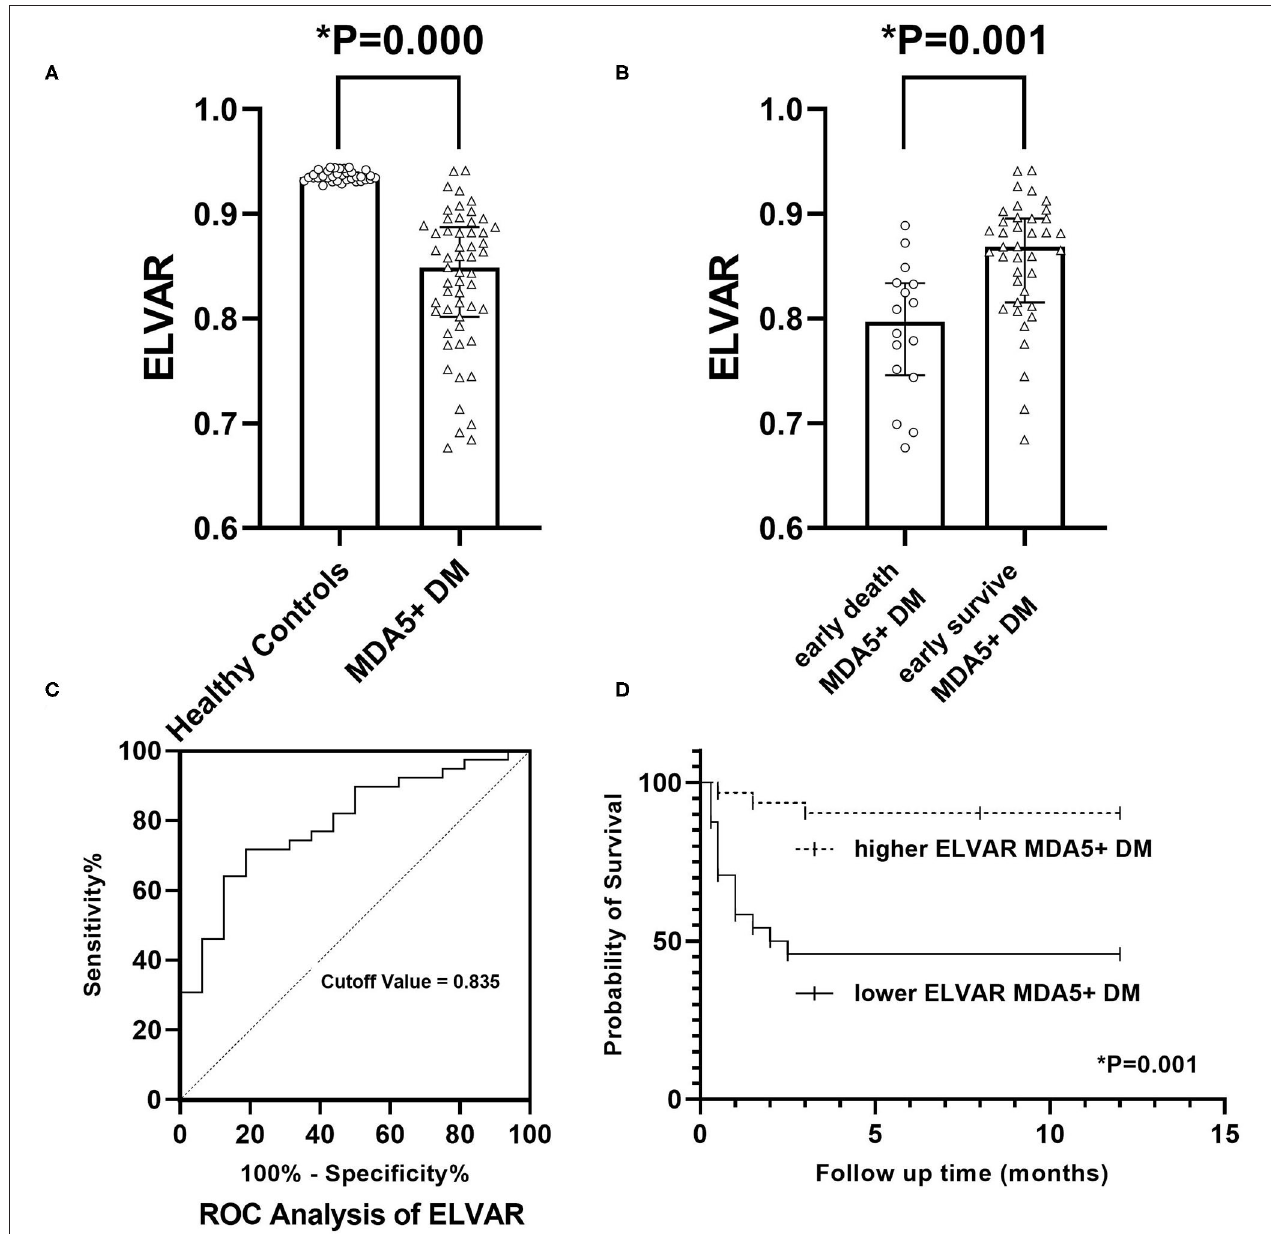
FIGURE 5 | Clinical significance of value of ELVA. (A) Comparison of ELVAR values between healthy controls and MDA5 + DM patients; (B) Comparison of ELVAR values between early death MDA5 + DM patients and early survival MDA5 + DM patients; (C) ROC analysis of ELVAR and best cutoff value was 0.835; (D) Comparison of 12-month Kaplan-Meier survival curve between higher ELVAR MDA5 + DM patients and lower ELVAR MDA5 + DM